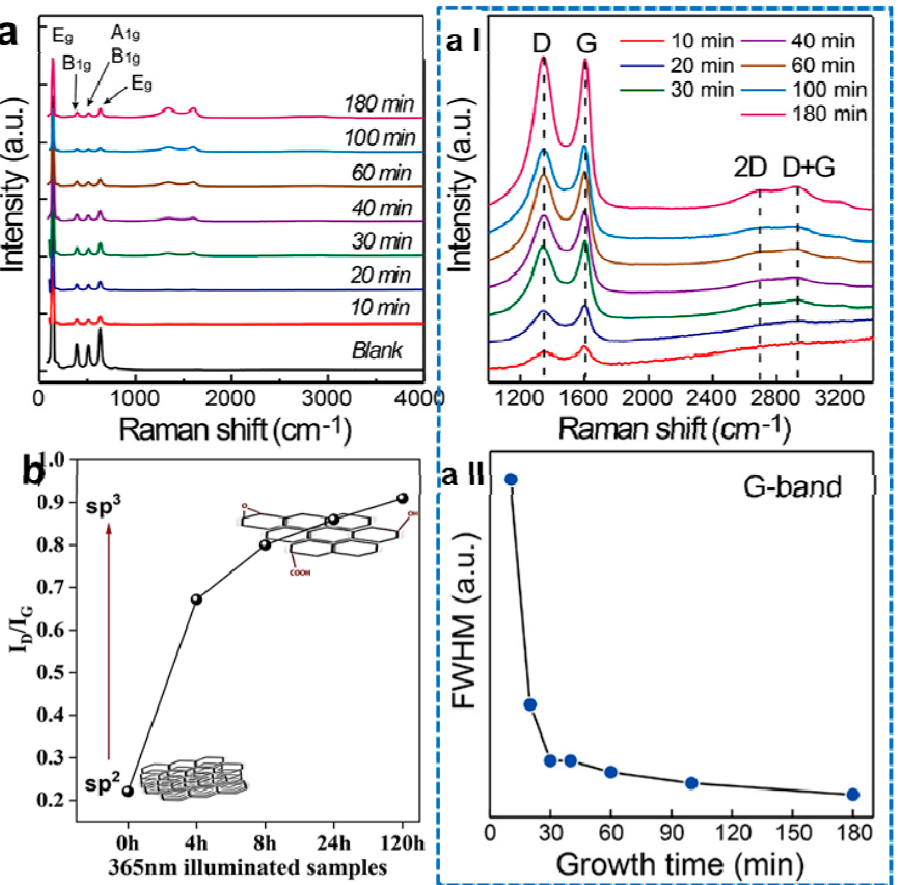
Figure 4. ( a ) Raman spectra of a series of TiO 2 /graphene samples prepared at different growth times, and the inset includes the ( I ) expanded view of spectra in the range of 1100–3300 cm − 1 , and ( II ) the plot of the FWHM of the deconvoluted G band as a function of growth time [143] (Reprinted with permission from [143] Copyright 2018 American Chemical Society); and ( b ) the I D /I G ratio as a function of increases in oxidation level (subjected here with increases in time) of GO in the composite [10] (Reprinted with permission from [10] Copyright 2022 John Wiley & Sons, Inc.).